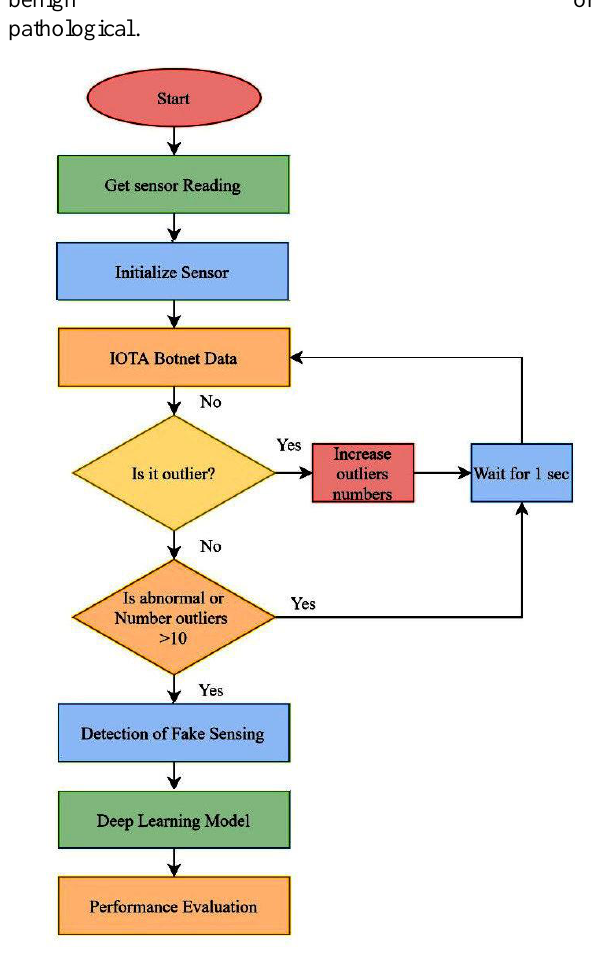
Figure 5. Deep Learning based IOTA